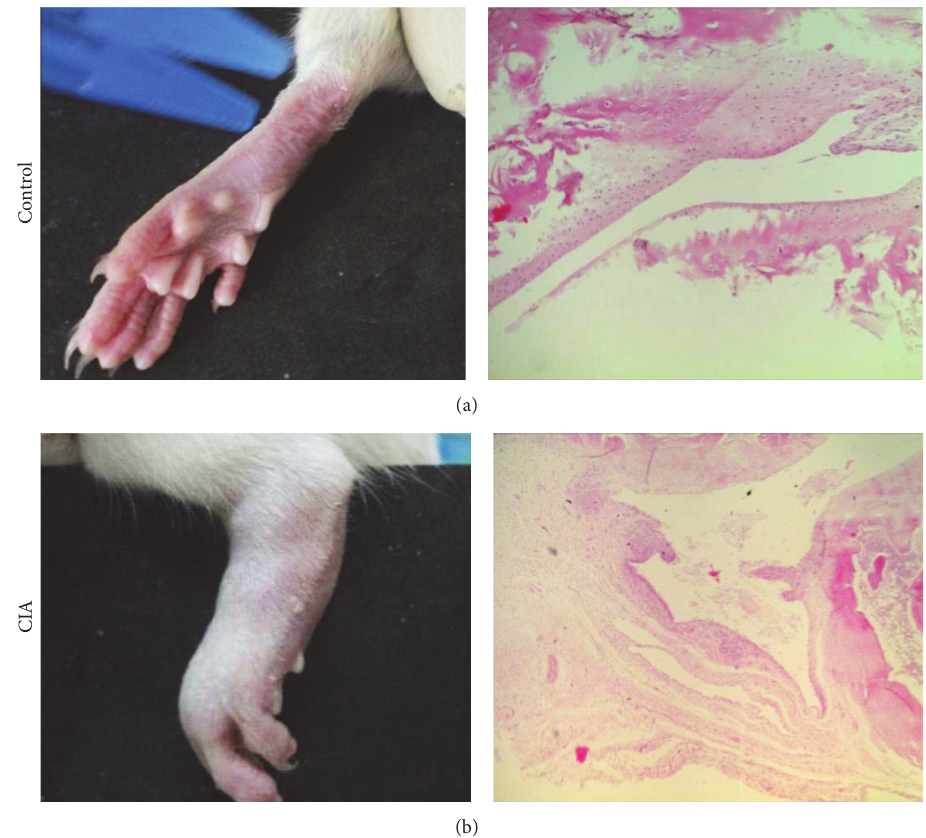
Figure 1: Establishment of rat collagen-induced arthritis. After day 17 of immunization, the macroscopic change of hind limbs and the histology of joint tissue sections from CIA rats and control rats were analyzed. All data are representative of one out of three independent experiments.